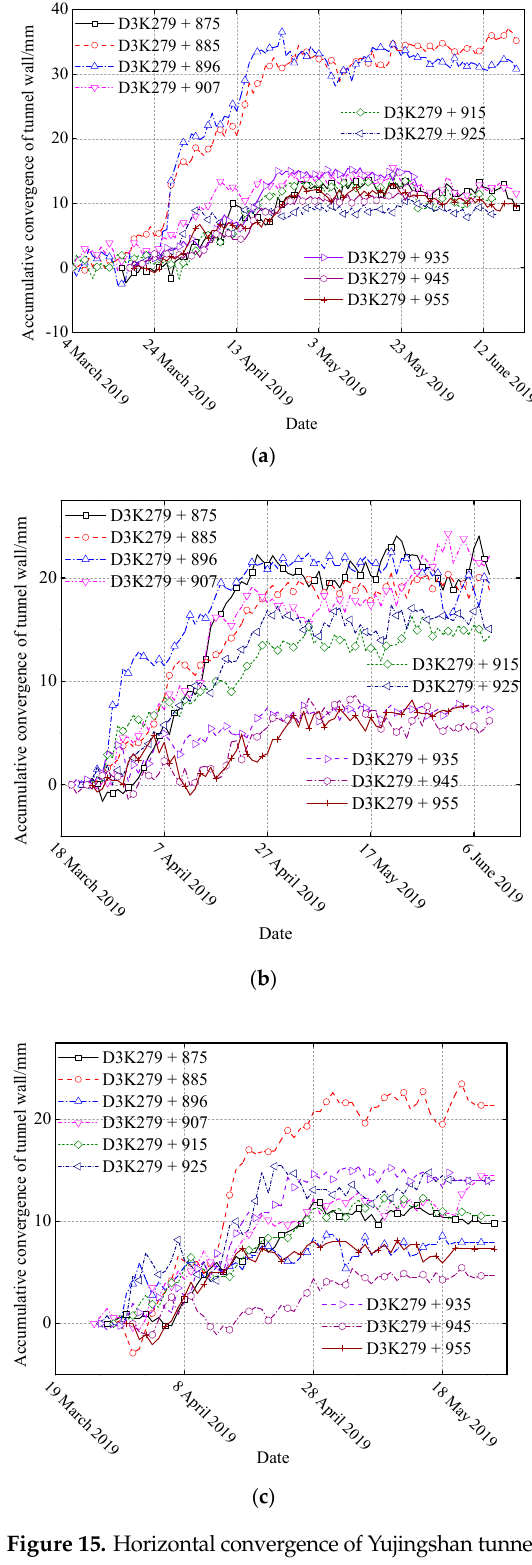
Figure 15. Horizontal convergence of Yujingshan tunnel on the ( a ) upper ( b ) middle and ( c ) lower steps.